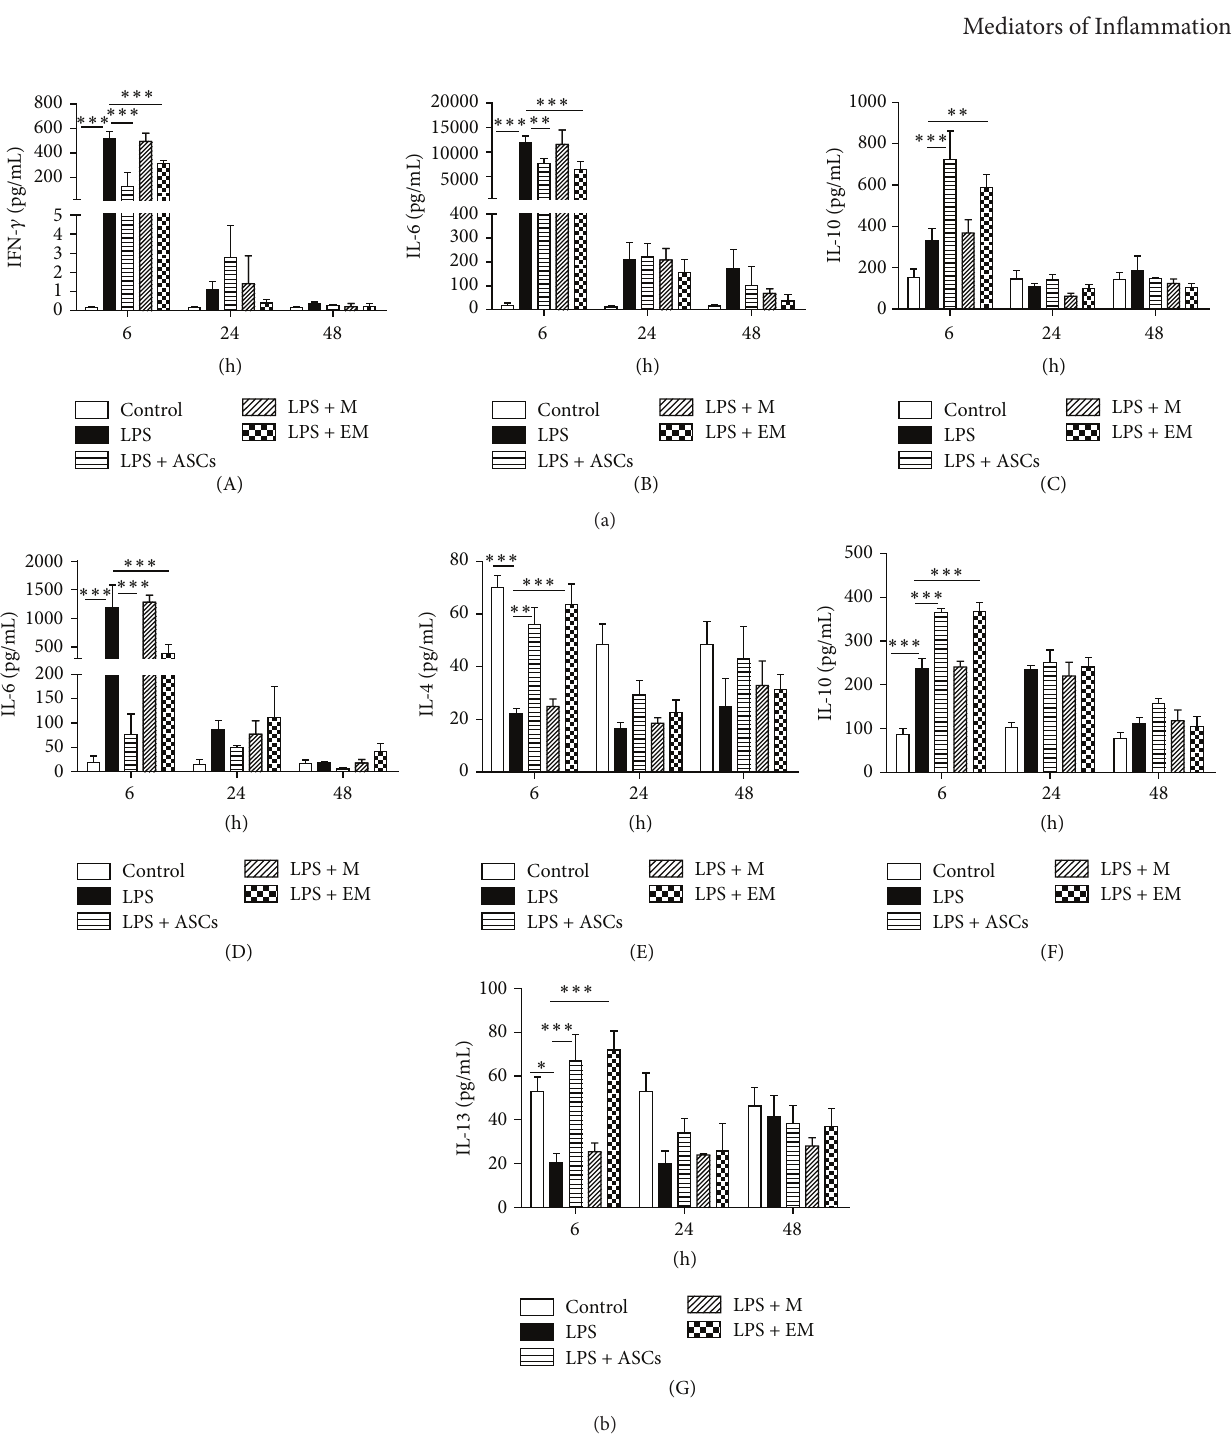
Figure 3: Infusion of educated macrophages (EM) alters the systemic inflammatory response to LPS. In each group, blood and BAL samples were collected at 6, 24, and 48h after LPS or PBS treatment. Cytokine concentrations were determined in a Luminex system. (a) Cytokine levels in serum (IFN- 𝛾 , IL-6, and IL-10). (b) Cytokine levels in BAL (IL-4, IL-6, IL-10, and IL-13). M = macrophages. All data are expressed as mean ± SEM; 𝑛 = 4 per group. ∗ 𝑝 < 0.05 ; ∗∗ 𝑝 < 0.01 ; and ∗∗∗ 𝑝 < 0.001